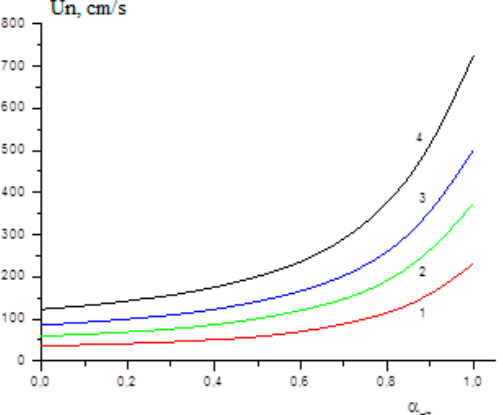
Figure 10. Calculated dependence of the laminar flame velocity on the hydrogen content α H2 at initial temperatures T 0 (K): 300 (1), 400 (2), 500 (3), 600 (4) (Adapted with permission from ref. [25], Copyright 2019, TORUS PRESS.).